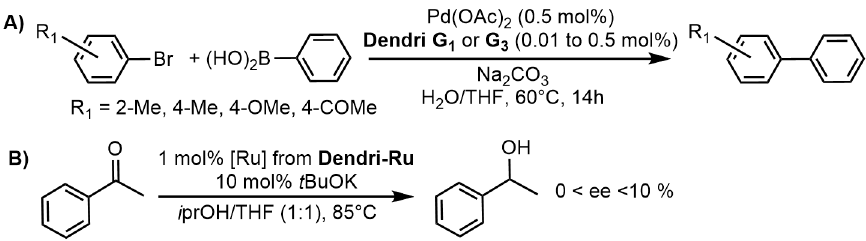
Figure 4. ( A ) Suzuki coupling catalyzed by Pd complexes of the dendrimers shown in Scheme 4A. ( B ) Transfer hydrogenation catalyzed by Ru complexes of the dendrimers shown in Scheme 4B.